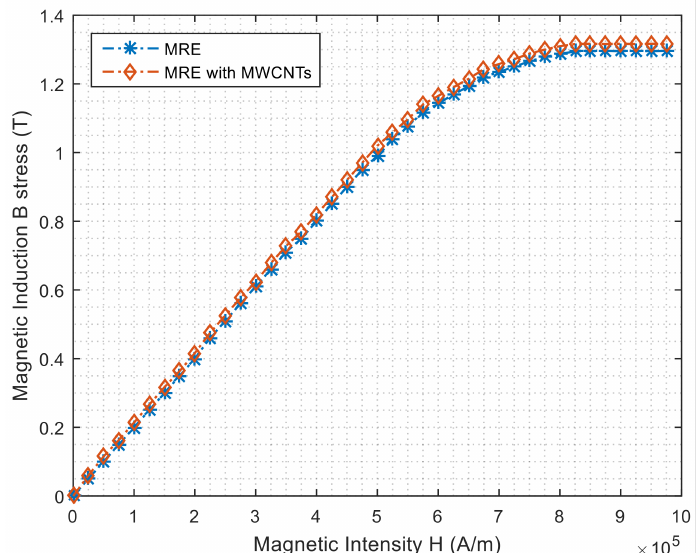
Figure 4. The saturated magnetic induction: MRE and MRE with MWCNTs is 1.296 T and 1.316 T respectively.